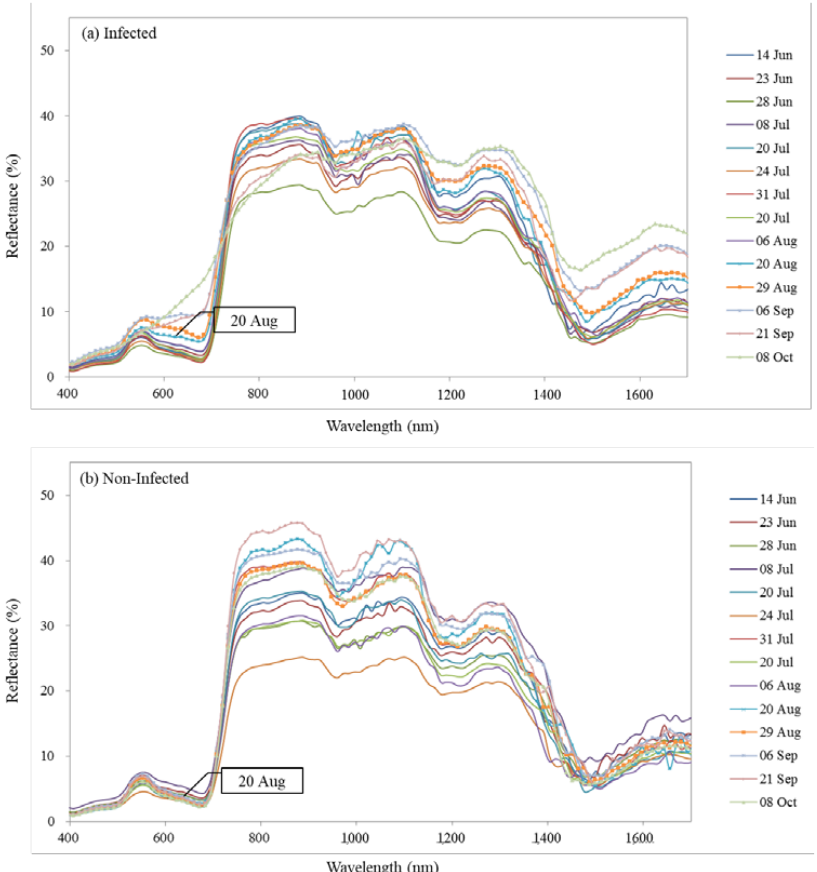
Figure 4. Changes in the leaf reflectance spectra of infected ( a ), and non-infected ( b )